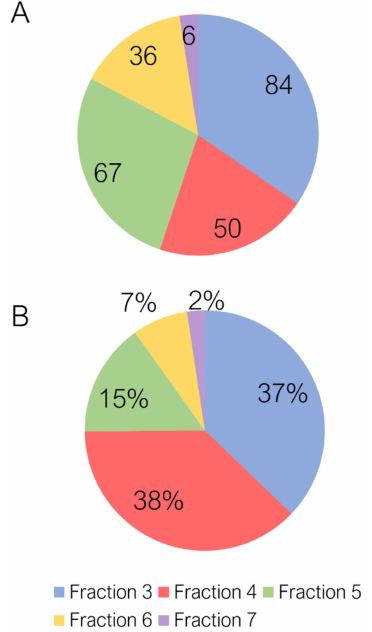
Figure 1. ( A ) Pie chart representing the number of tentatively identified phenolic compounds in the five analyzed fractions (F3–F7) and ( B ) the peak areas (%) of the five analyzed fractions (F3–F7) with the respect of the total peak area of tentatively identified phenolic